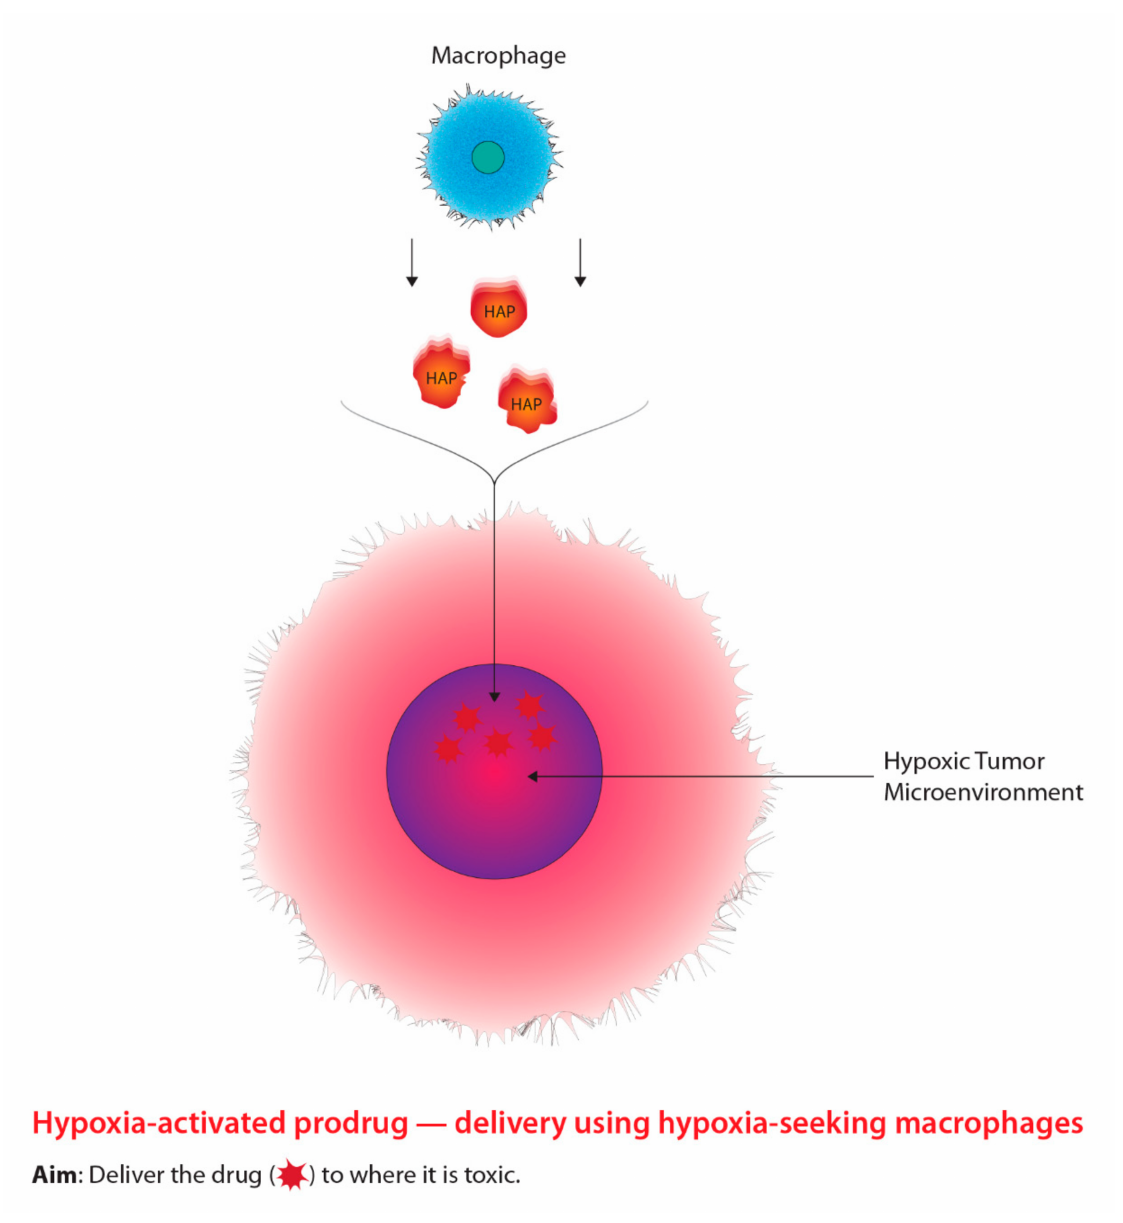
Figure 4. The concept underlying the targeting of hypoxic cells using prodrugs tagged to tumour-seeking